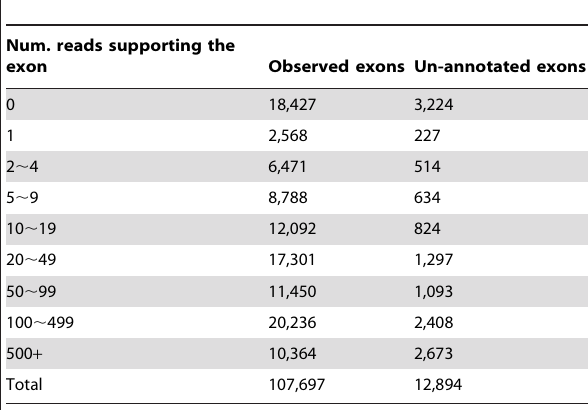
Table 2. Number of observed exons from the RNA-Seq data and new findings not annotated in RefSeq.